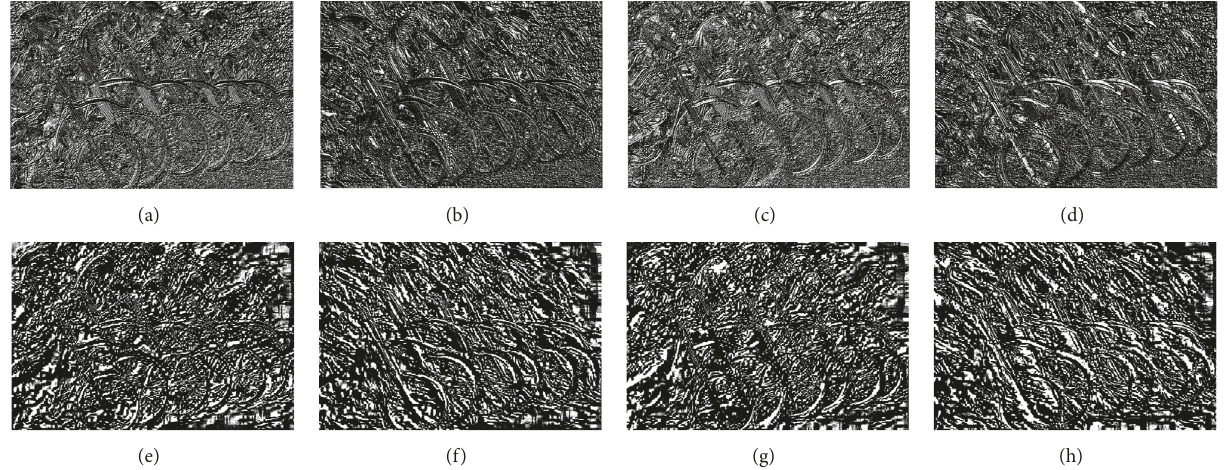
Figure 5: The texture maps of an enhanced reference image and its distorted version.